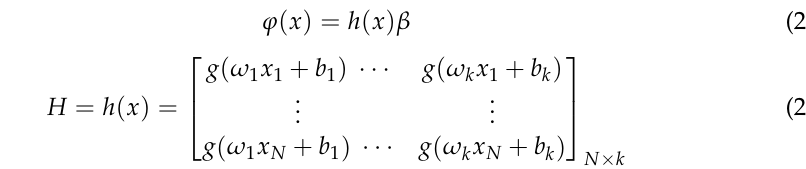
Figure 2. GWO algorithm flow chart. In the formula, D is the distance between grey wolf and prey; t position of the prey; is the number of iterations; t X is the current position of the 0,1 r ,r ; 𝛼 is the convergence factor; and A and C are the coefficient grey wolf; 1 2 vectors.